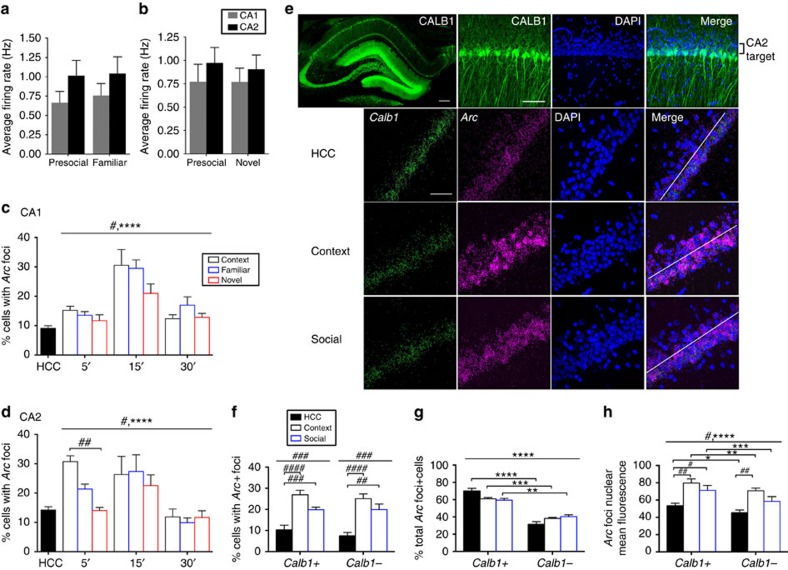
CA2 activity levels are not modified by social stimuli.(a,b) Average firing rate before and during exposure to social stimuli for CA1 and CA2. No differences in average firing rates were detected for CA2 neurons during familiar exposure (median(pre-social)=0.5850, median(familiar)=0.5271, W=43.0, P>0.05, n=49 CA2 neurons) or novel exposure (median(pre-social)=0.5278, median(familiar)=0.5280, W=−162.0, P>0.05, n=55 CA2 neurons, Wilcoxon signed-rank test) or for CA1 neurons during familiar exposure (median(pre-social)=0.3210, median(familiar)=0.3800, W=336.0, P>0.05, n=55 CA1 neurons) or novel exposure (median(pre-social)=0.2875, median(familiar)=0.3682, W=431.0, P>0.05, n=58 CA1 neurons, Wilcoxon signed-rank test). (c,d) Time course of percentage of cells with Arc foci in CA1 and CA2 following spatial and social exploration (CA1: main effect of time F(2,48)=25.13, P<0.0001; main effect of condition F(2,48)=3.198, P=0.0497, two-way ANOVA. Bonferroni post hoc tests revealed no significant difference between conditions at any time point; however, context versus novel at 15 min trended towards significance (P=0.055). CA2: main effect of time F(2,48)=18.72, P<0.0001; main effect of condition F(2,48)=3.400, P=0.0416, two-way ANOVA. Bonferroni post hoc results are shown for the main effect of condition. See Supplementary Table 1 for post hoc tests for the main effect of time. HCC conditions are shown for comparison but were not included in the statistics. n=5–9 rats per condition). (e) Immunostaining of calbindin-1 (CALB1) in dorsal hippocampus and CA1 to delineate the target layer of CA2 axons and representative smFISH images probing for Calb1 and Arc across conditions. (f) Percentage of Calb1+ or − cells expressing Arc foci across conditions (main effect of condition F(2,13)=19.59, P=0.0001, two-way paired ANOVA with Bonferroni post hoc tests; n=5–6 rats per condition). (g) Per cent total Arc foci+cells that are Calb1+ or Calb1− (main effect of Calb1 expression F(1,13)=107.8, P<0.0001, two-way paired ANOVA with Bonferroni post hoc tests). (h) Arc mean nuclear fluorescence per cell measured in Arc foci+cells as a function of Calb1 expression (main effect of Calb1 expression F(1,13)=56.94, P<0.0001; main effect of condition F(2,13)=8.155, P=0.0051, two-way paired ANOVA with Bonferroni post hoc tests). Scale bar, 200 and 50 μm (left and right/lower). #,*P<0.05; ##,**P<0.001; ###,***P<0.001; ####,****P<0.0001. Error bars are s.e.m.